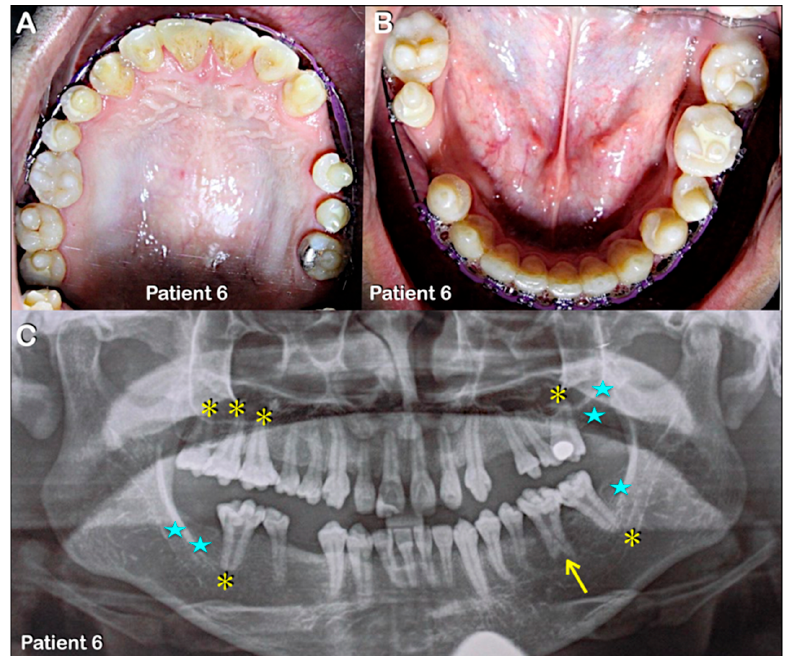
Figure 5. Patient 6. ( A – C ) Patient 6. ( A , B ) Permanent dentition. Round-shaped permanent molars, molars with multiple supernumerary cusps, and premolars with single prominent cusps. ( C ) Panoramic radiograph showing agenesis of second and third permanent molars (blue stars) and single-rooted permanent molars (yellow asterisks). Note severe taurodontism (yellow arrow).